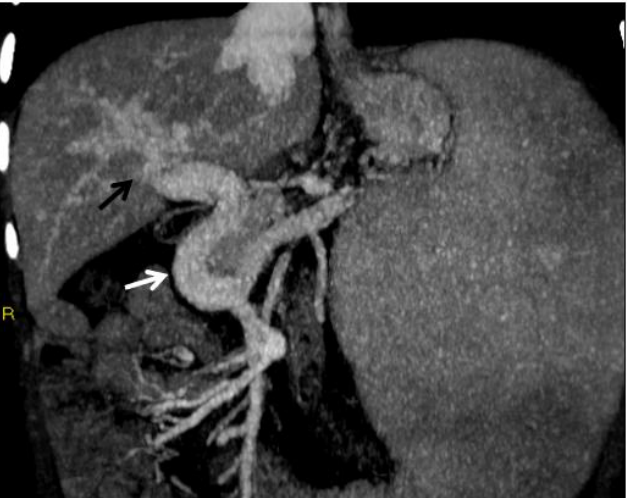
Figure 1. CT of an 8-year-old female who presented with hematemesis due to variceal bleeding. Portal phase, maximum intensity projection CT image reformatted on the coronal plane shows a large, tortuous collateral vein of the extrahepatic cavernoma at the porta hepatis (white arrow). Cavernous transformation of the intrahepatic portal branches is also seen (black arrow).